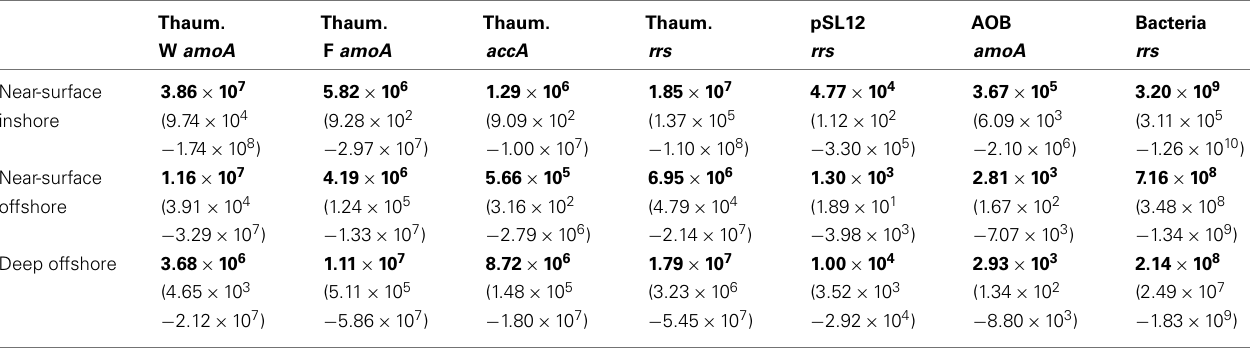
Table 1 | Summary of qPCR-estimated gene abundances (copiesL − 1 ) determined for samples from the northern Gulf of Mexico.